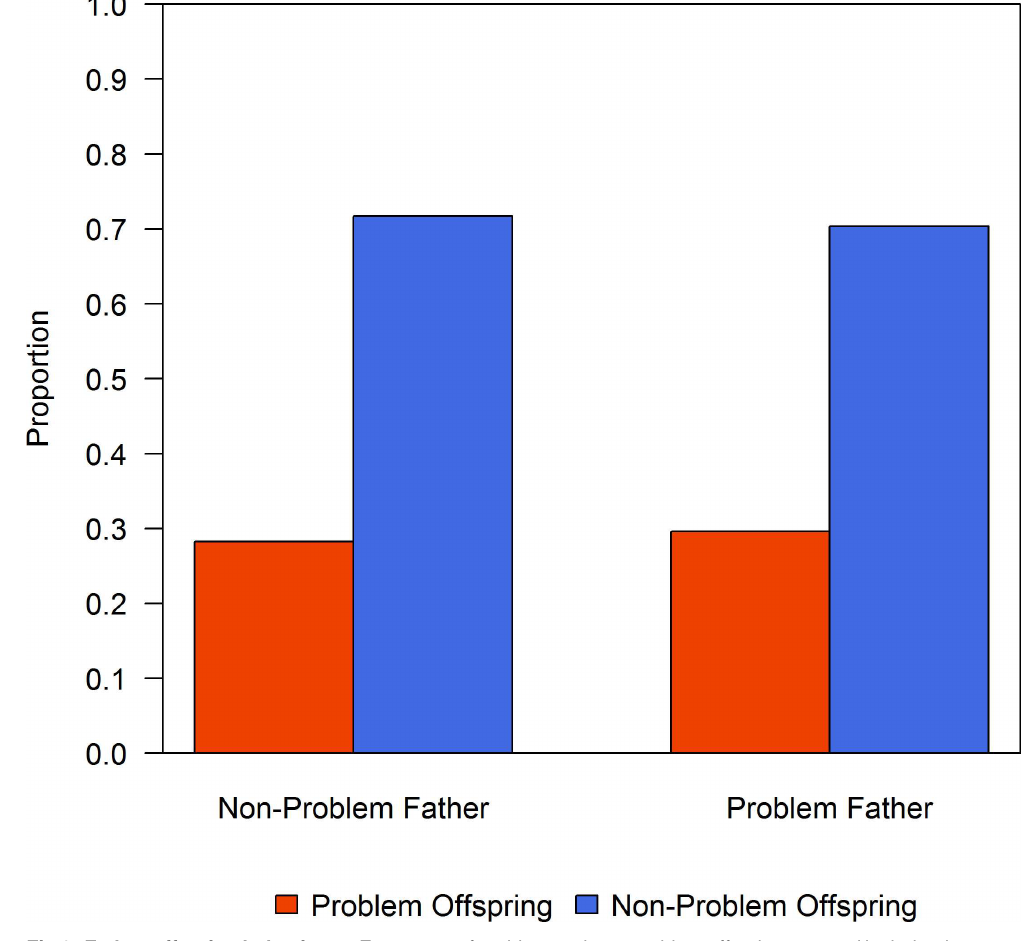
Fig 2. Father-offspring behaviours. Frequencyof problemand non-problem offspring groupedby behaviourtype of their father.